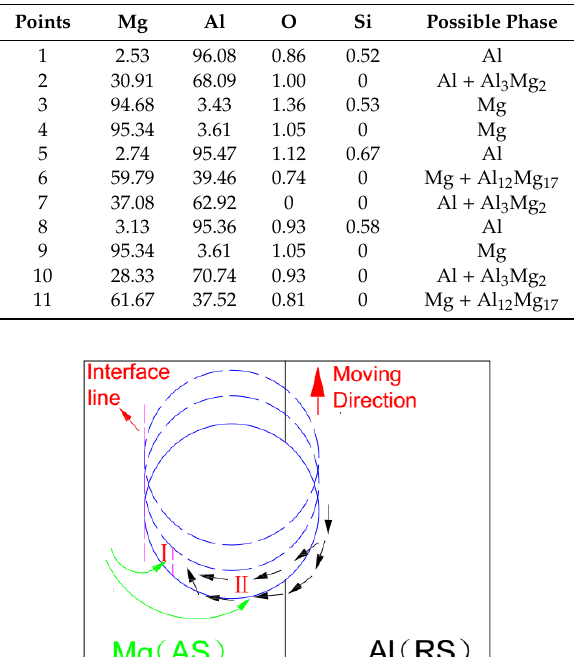
Table 3. EPMA analysis of T2, T5 and T7 (wt%).